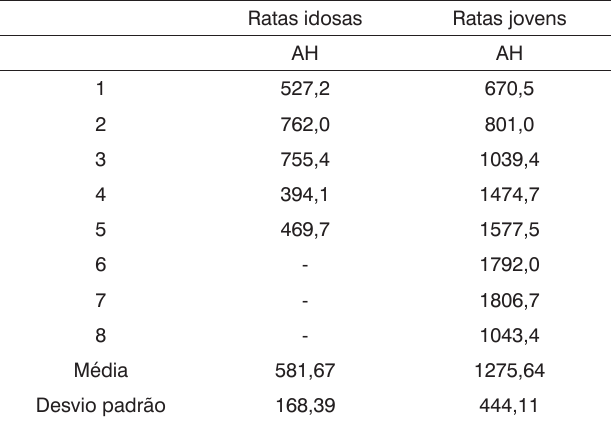
Tabela 2. Concentração de AH, em ng/mg de peso seco, em pregas vocais de ratos de acordo com os grupos.